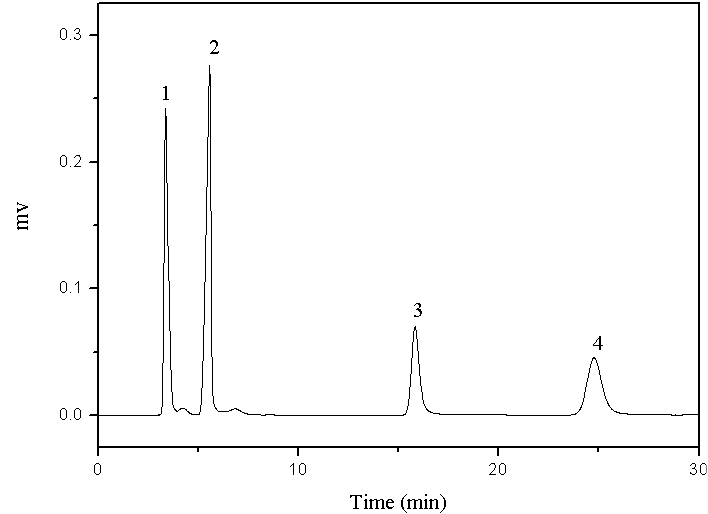
Figure 6. Chromatogram of the four target compounds with 0.02 mol/L of NaH mobile phase additive. 1: chlorogenic acid, 2: caffeic acid, 3: scoparone, 4: